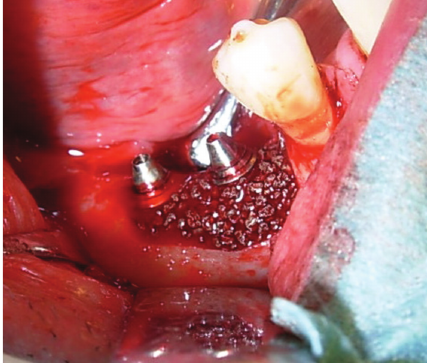
Figure 3: Clinical example of PTG implanted in marked vertical defect around implants in the lower right jaw of patient number 2.